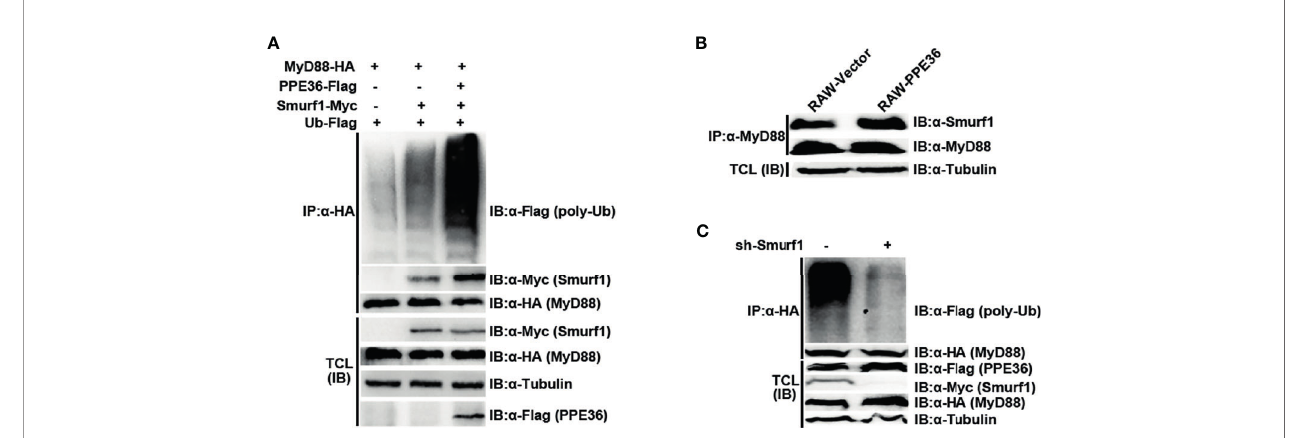
FIGURE 7 | PPE36 promoted Smurf1-mediated ubiquitination and degradation of MyD88 protein. (A) Ubiquitination of MyD88 protein and the interaction of MyD88 with E3 ligase Smurf1 in HEK293T cells, which were co-transfected with pPPE36-Flag, pMyD88-HA, pSmurf1-Myc, and pUb-Flag. (B) Interaction of MyD88 with the E3 ligase Smurf1 in the RAW-PPE36 cells. (C) HEK293T cells were transfected with pSmurf1-Myc for 24 h and then transfected with sh-Smurf1 or control shRNA; 12 h later, MyD88 ubiquitination was monitored by immunoprecipitation assays. All data were representative of at least three independent experiments. TCL, total cell lysates; IP, immunoprecipitation; IB,